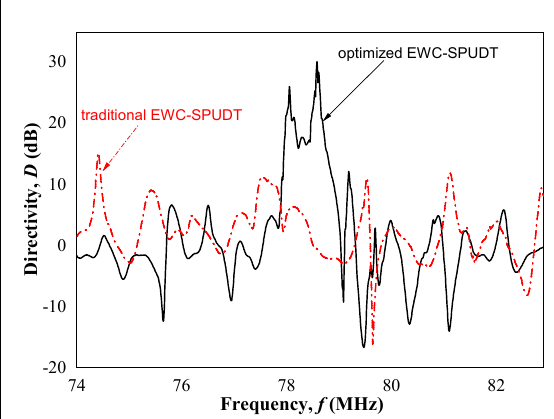
Figure 11. Comparison on the directivity of test devices with optimized EWC-SPUDT cells and with traditional EWC-SPUDT cells.